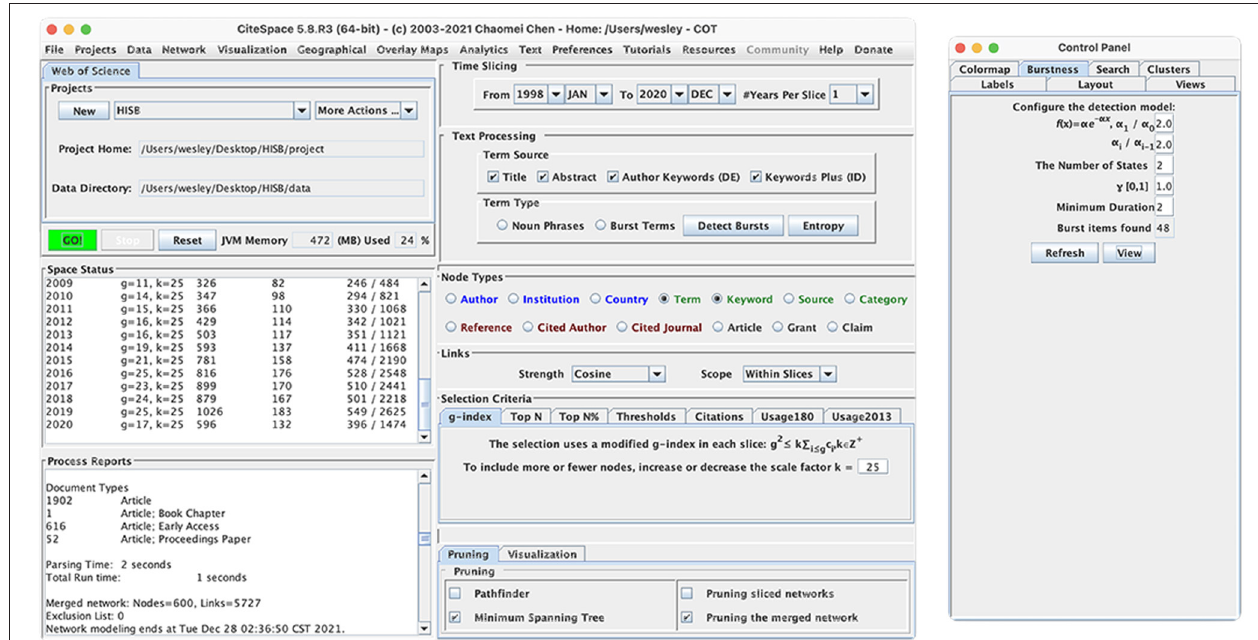
FIGURE 4 | Citespace keywords burstness parameter